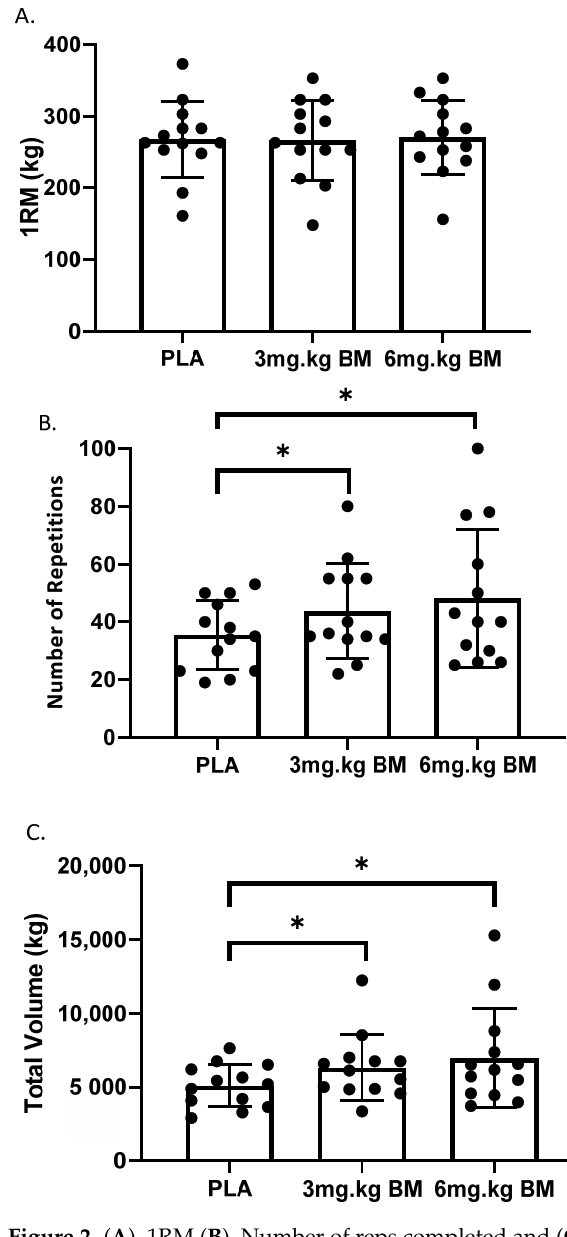
Figure 2. ( A ). 1RM ( B ). Number of reps completed and ( C ). Total volume lifted during the leg press exercise in strength-trained females, with PLA, 3 and 6 mg · kg − 1 BM. * p < 0.05 condition effect.